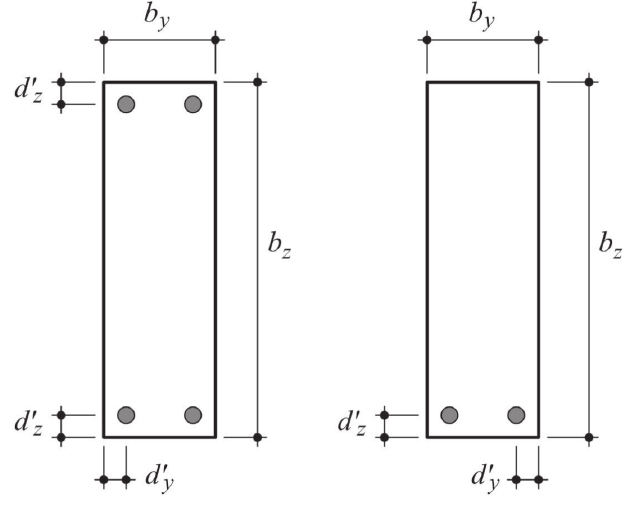
Typical cross-sections with and without compression